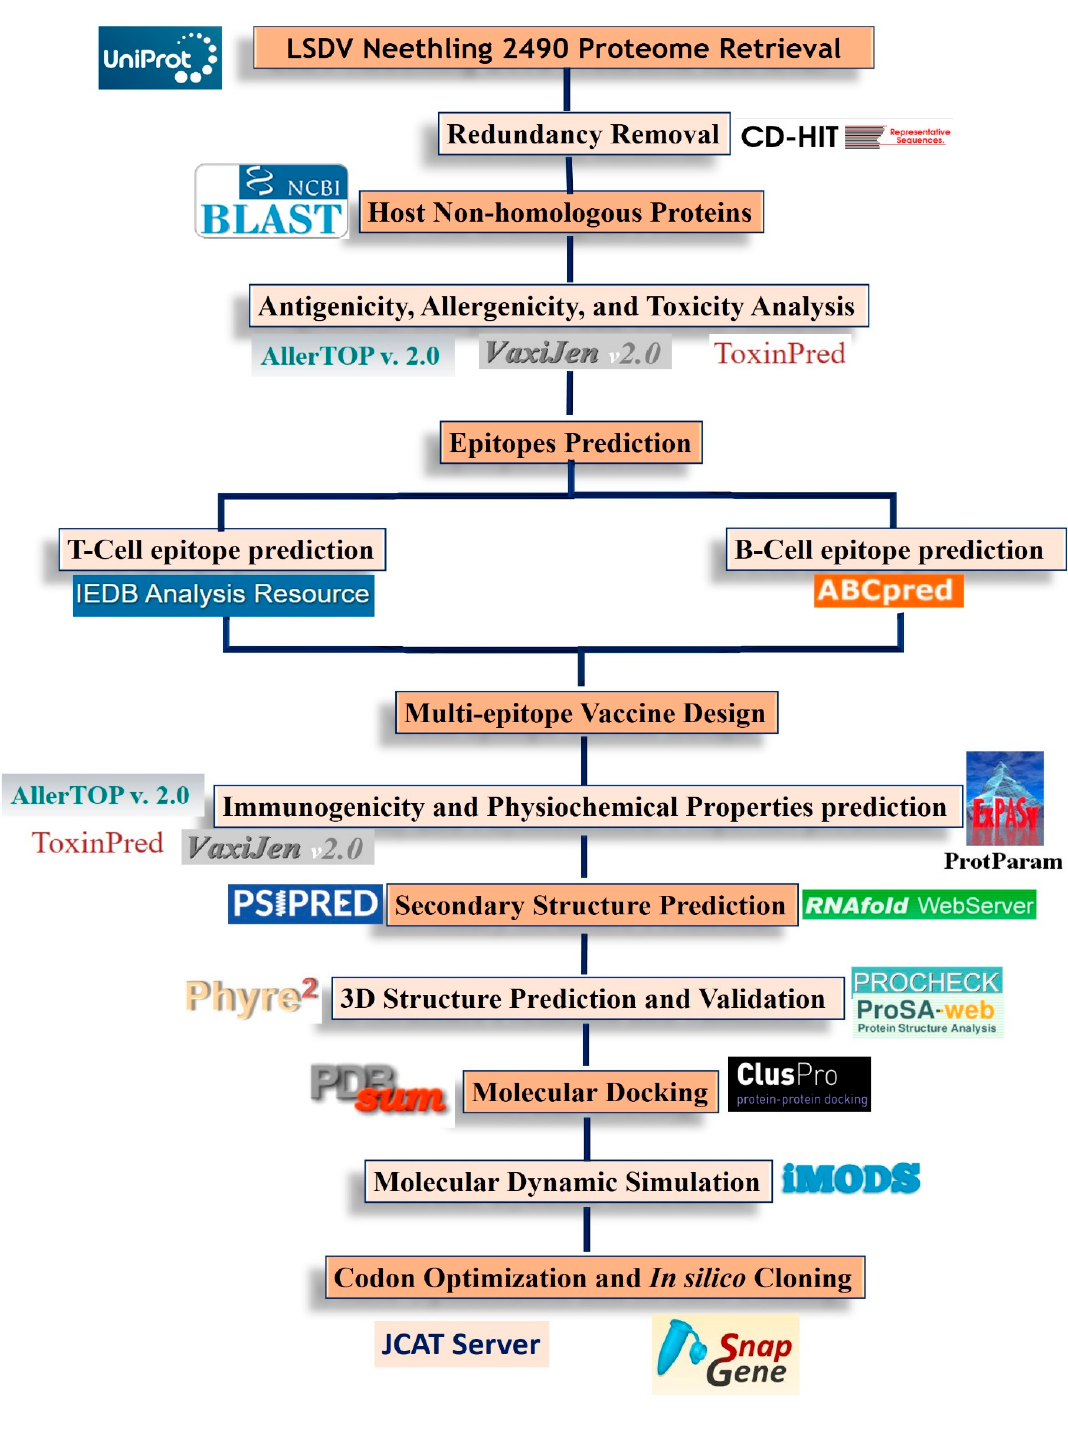
Figure 1. The systematic work fl ow of the current